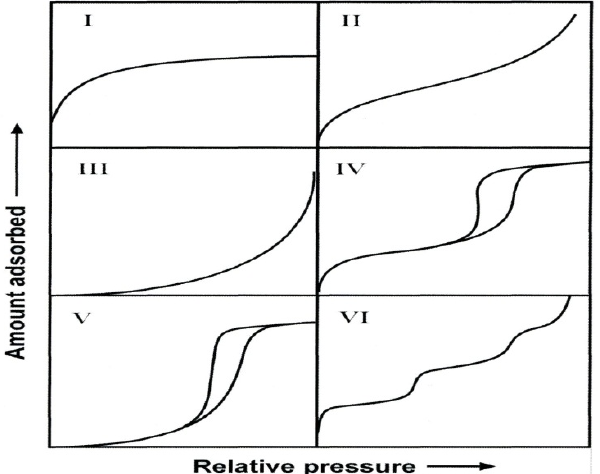
Figure 3. The IUPAC classification of adsorption isotherms showing both the adsorption and desorption pathways. Note the hysteresis in types IV and